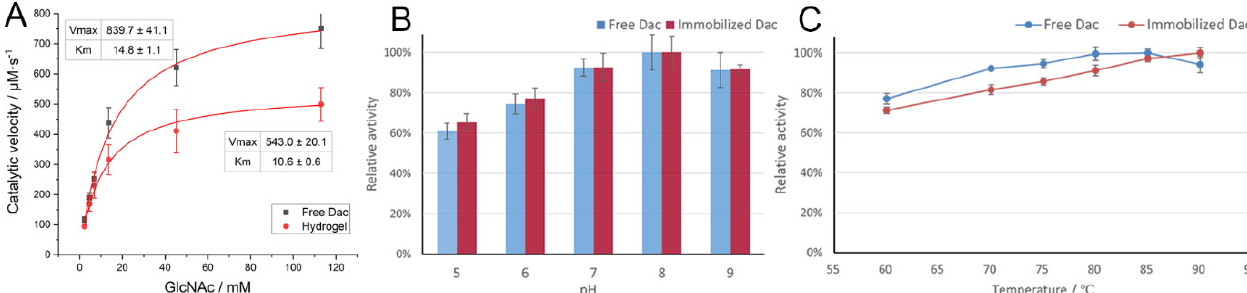
Figure 6. Characterization of enzyme immobilization. ( A ) Non-linear fitting for kinetic constant measurements of free and immobilized Dac. Reactions were performed at pH 8.0 and 80 °C. ( B ) Relative enzyme activities of free and immobilized Dac at different pH, ranging from 5.0 to 9.0. ( C ) Relative enzyme activities of free and immobilized Dac at different temperatures, ranging from 60 °C to 90 °C.